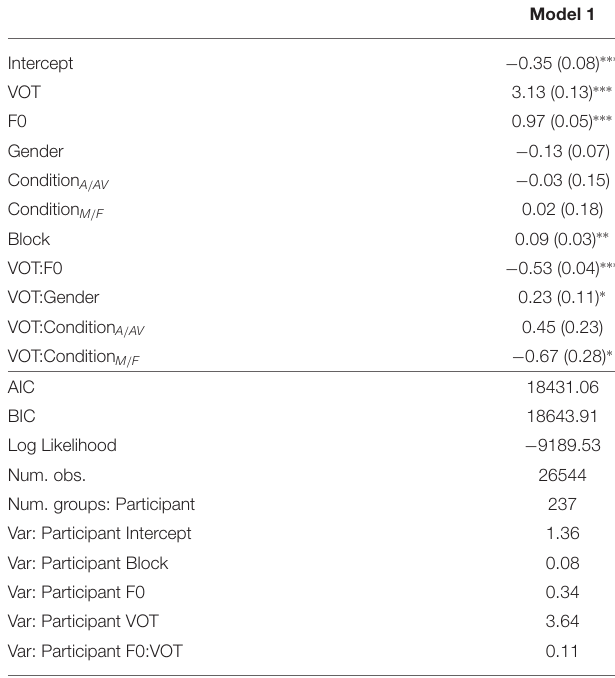
TABLE 3 | Estimates for all predictors in Model 1.